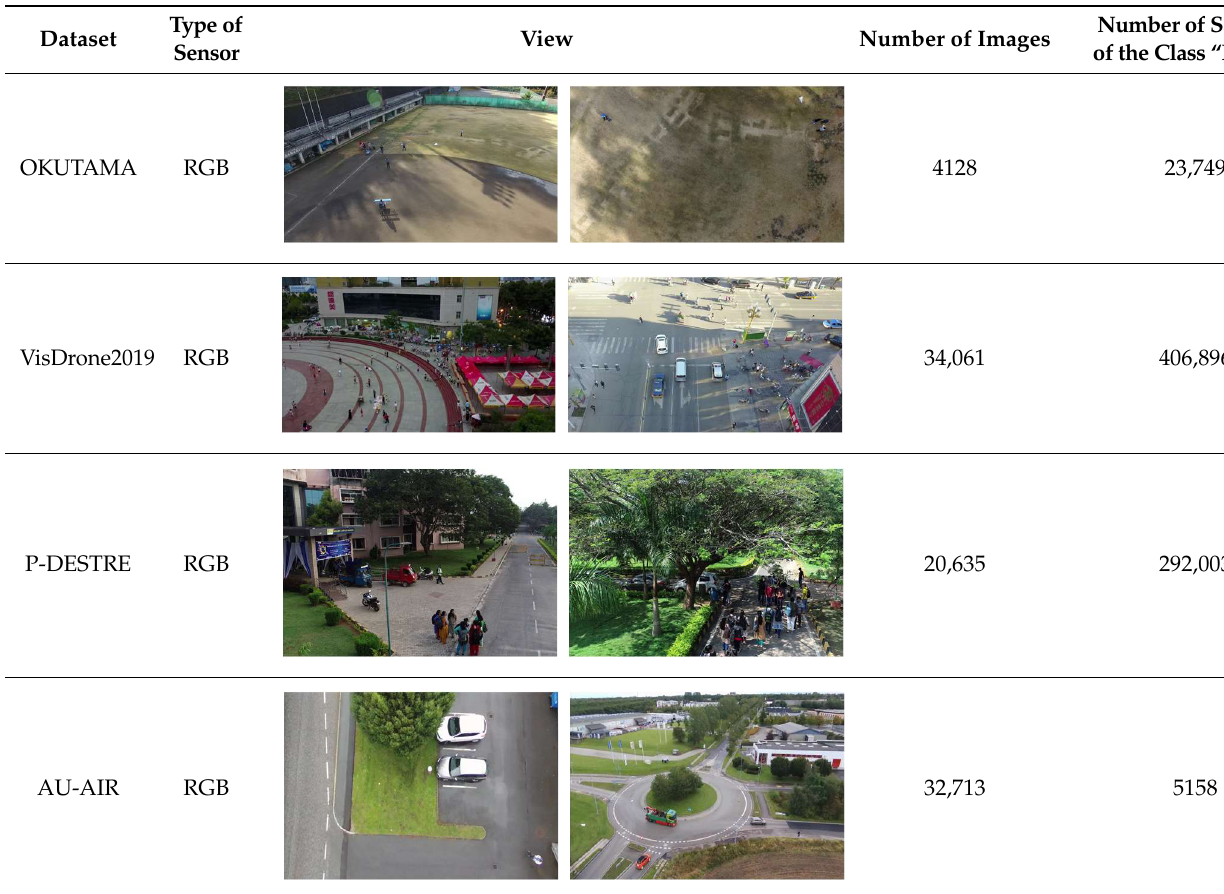
Table 6. Views from each selected dataset for the training process.